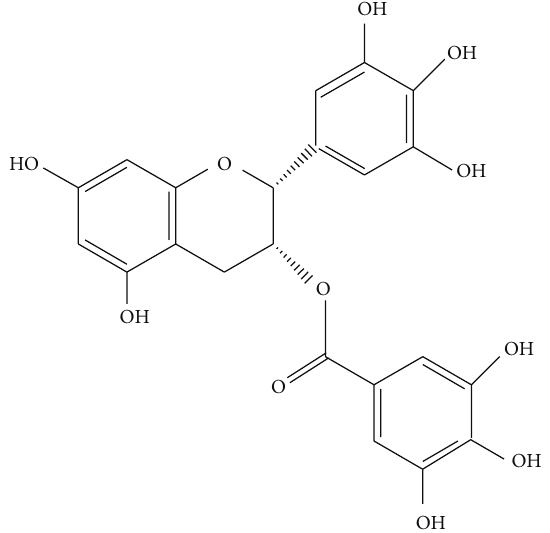
Figure 1: Chemical structure of ( − )-epigallocatechin-3-gallate (EGCG), the most abundant and most active catechin derivative from green